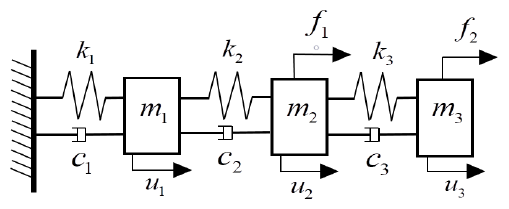
Figure 3. Multi-load of multiple-degree-of-freedom system.